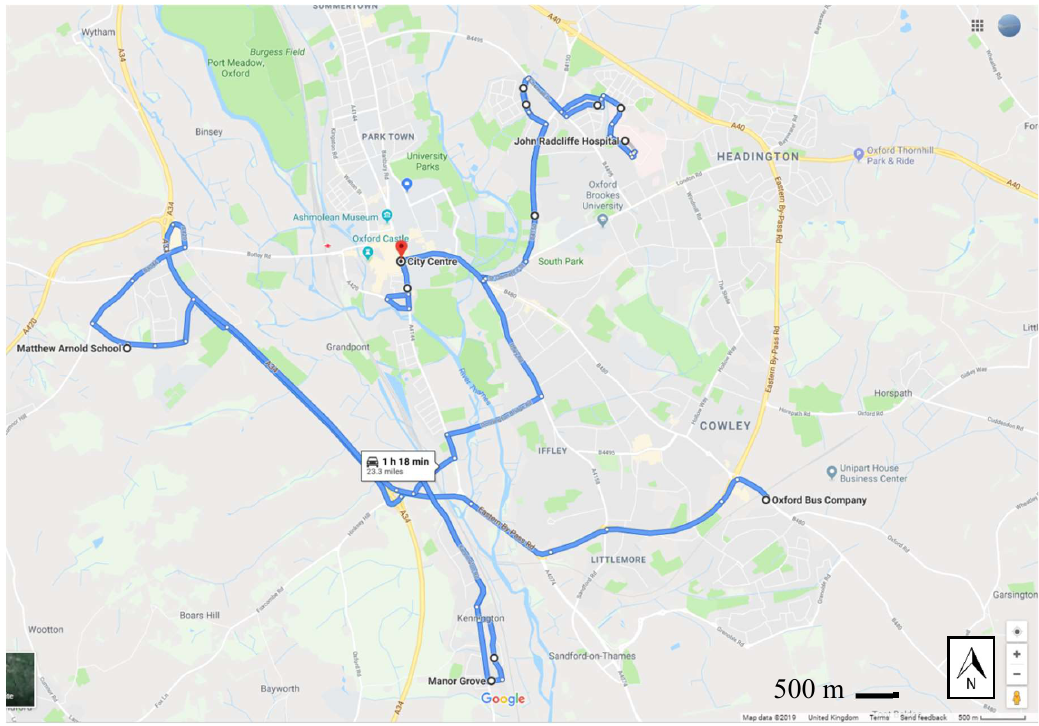
Figure 5. Routes taken by Euro V bus in the second part of the day (map data © Google).